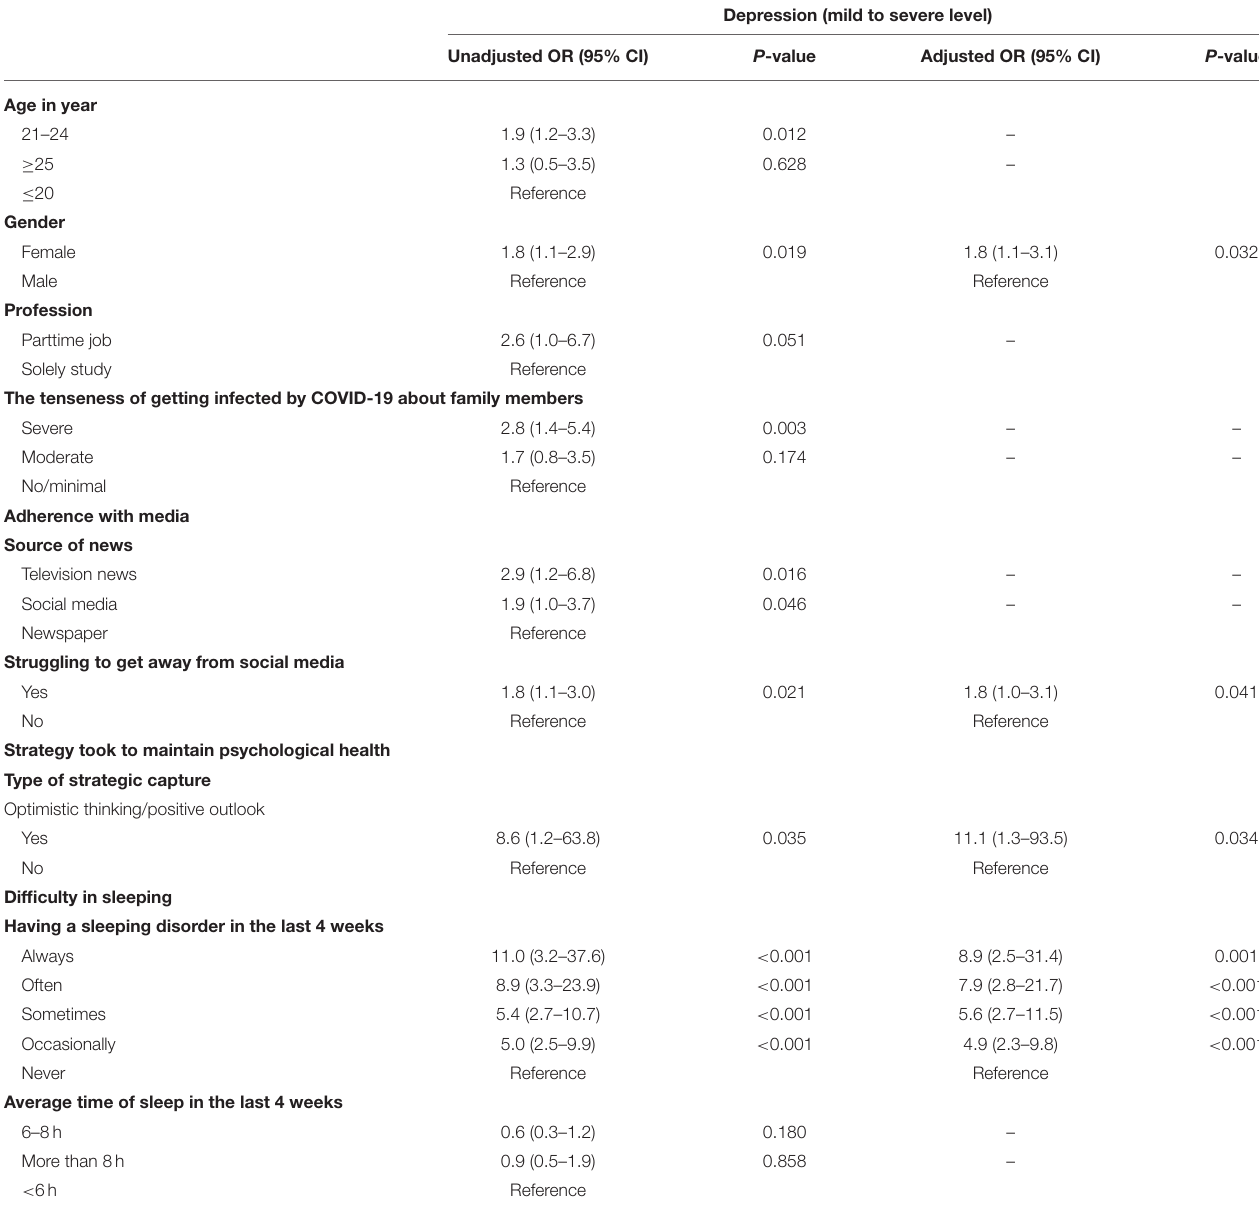
TABLE 2 | Logistic regression analysis of medical student who had depression for mild to severe level during COVID-19 pandemic, 2020